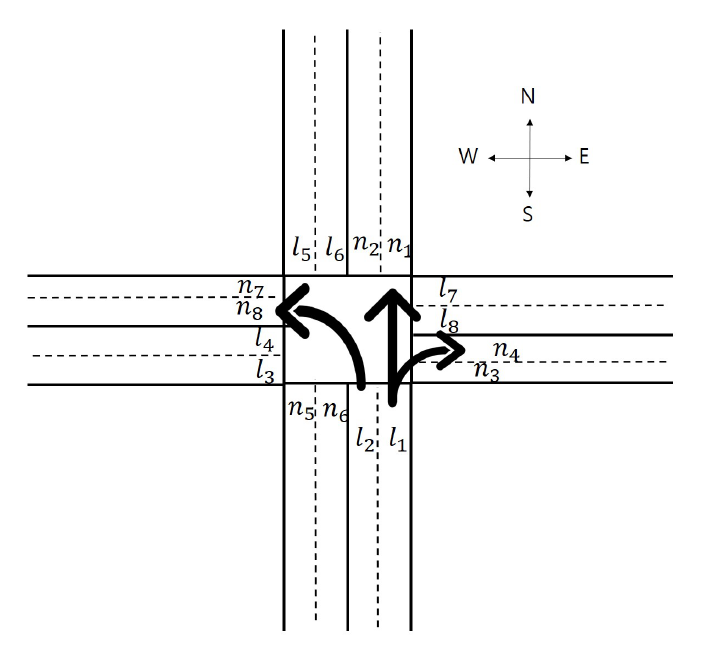
Figure 5. A 4-way target